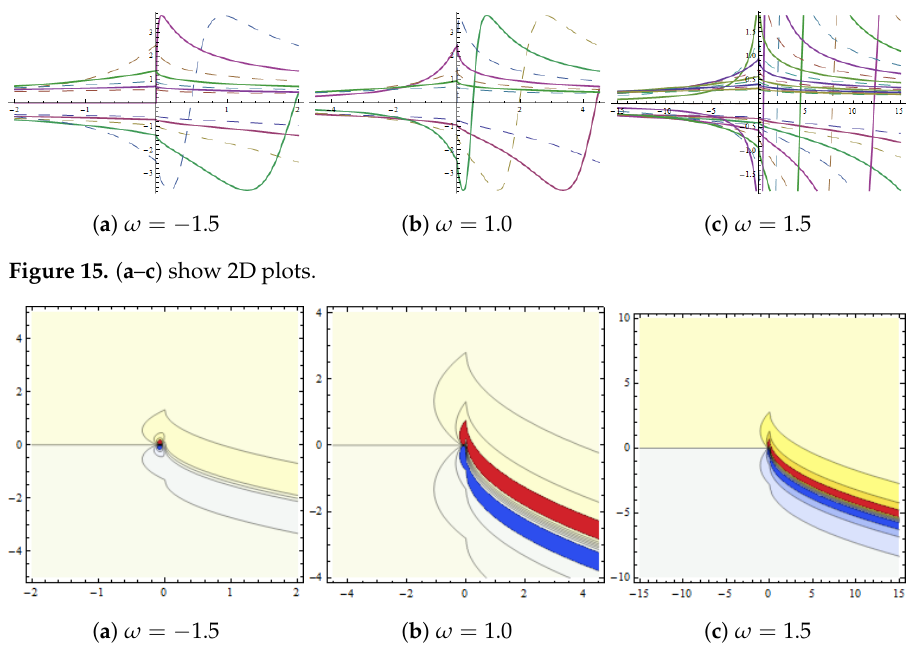
Figure 16. Behaviour of v ( x , t ) in Equation (39) presented with β 1 = 1.3, β 2 = 0.2, β 3 = 1.5, β 4 = 0.4, ζ = 0, Q = 5.2, w 2 = 0.1, w 3 = 3 and φ = 1.4. ( a – c ) show contour graphs for various values of ω .